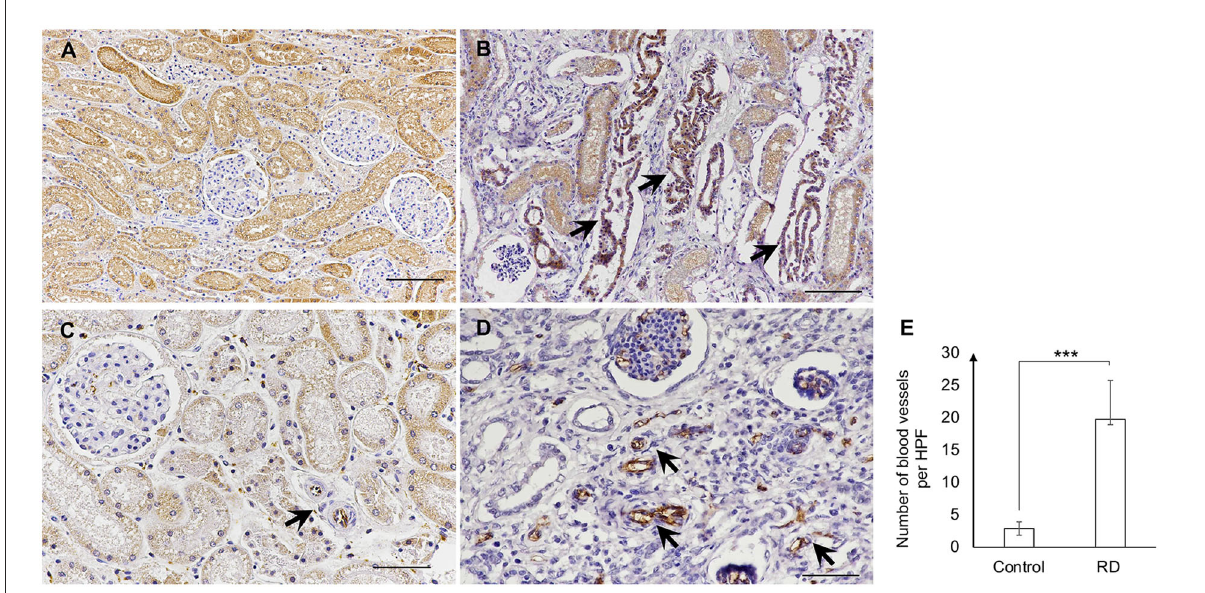
FIGURE4 (A,B) The positive labeling of BCL-2 in the negative control dog (A) and the affected dog (B) . Strong labeling of BCL-2 showed the localization of immature (fetal) tubules (arrows) (B) . (C,D) The CD31 (PECAM-1) positive labeling in the blood vessels of the negative control dog (C) and the affected dog (D) . The blood vessels (arrow) were labeled within glomeruli and surrounding areas (Immunohistochemistry, Mayer’s Hematoxylin counterstained, scale bar = 50 µ m). (E) The number of blood vessels per HPF (40X) in the negative control dog (Control) and the affected dog (RD). Blood vessel count was performed via the positive label of CD31 (PECAM-1) in the kidney of dogs. Data were displayed as mean ± SD. *** The significant difference among dogs ( p < 0.01) was evaluated by the t -test, using the SAS software version 9 (SAS Institute, Inc.,